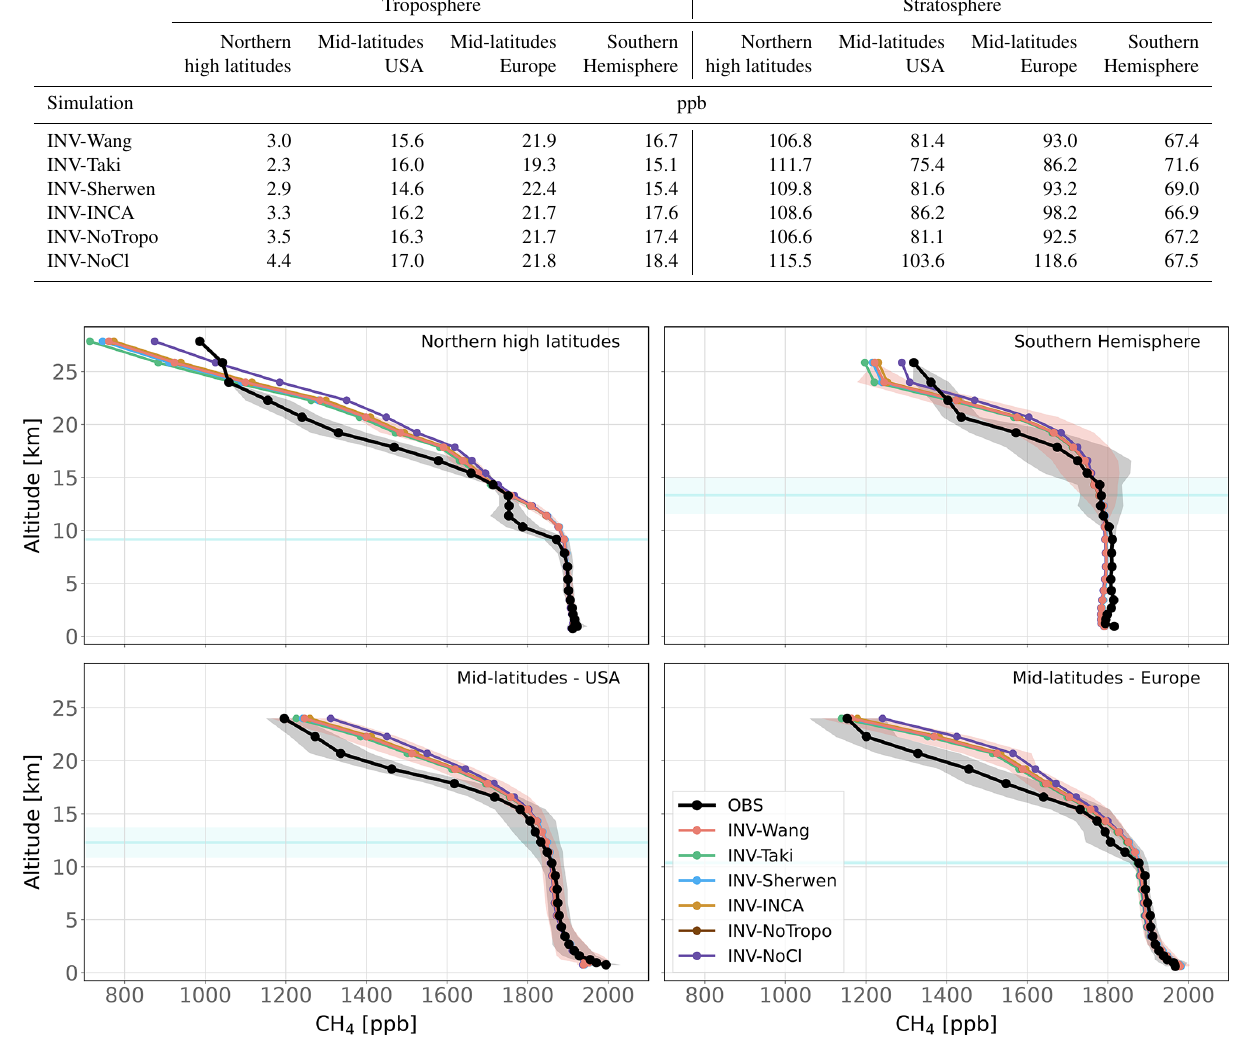
Figure 4. Observed and simulated CH 4 vertical profiles for four regions. All available vertical profiles in each region have been averaged. Shaded areas indicate the standard deviations of this average. The blue line and its associated shaded area show the mean altitude of the tropopause and its standard deviation over the vertical profiles in the